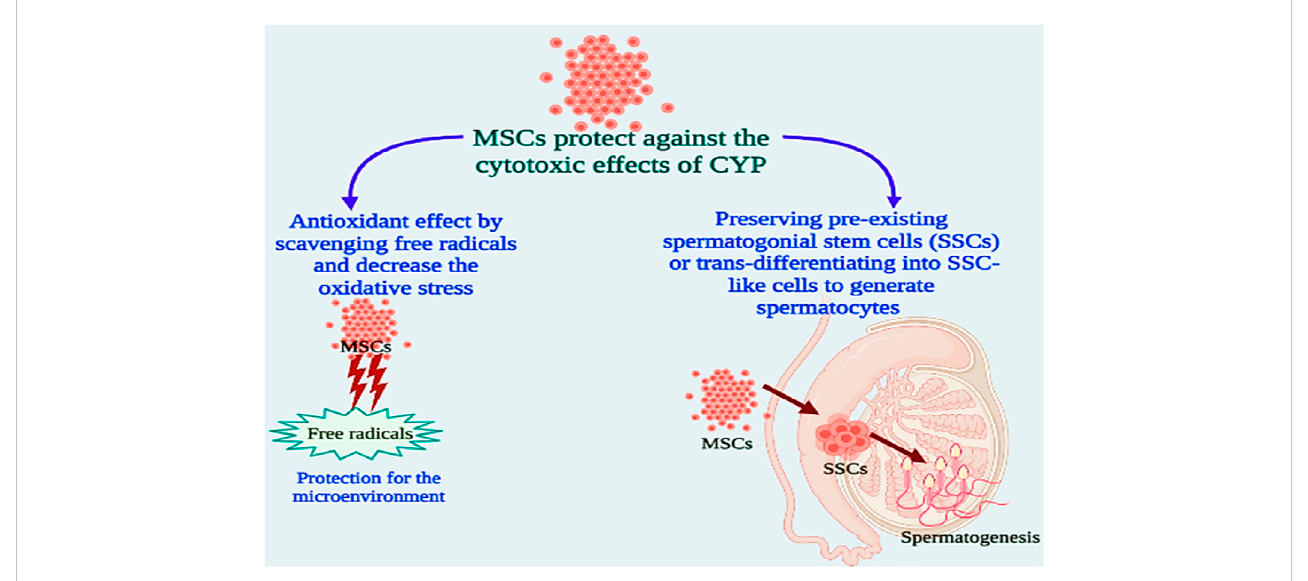
FIGURE 7 Possible mechanisms for the protective effects of MSCs against cytotoxicity of